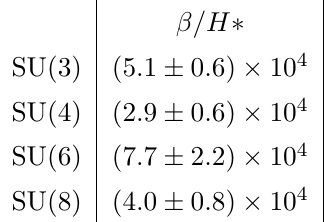
Table 1. Values of the parameter β/H ∗ for SU( N ). Errors are estimated by calculating β with different coefficients c i and d i which also give good fits to lattice